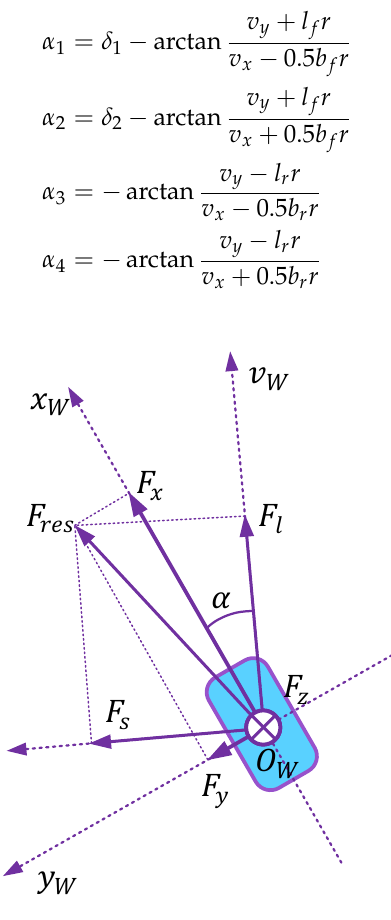
Figure 6. Friction forces acting on a wheel. F l and F s are aligned with the actual movement direction of the wheel which is indicated by the vector v W . Vector F res is the sum of F l and F s . The longitudinal and side forces F x and F y can be achieved by the projection of F res on the ( Oxy ) W , which is in association with the wheel